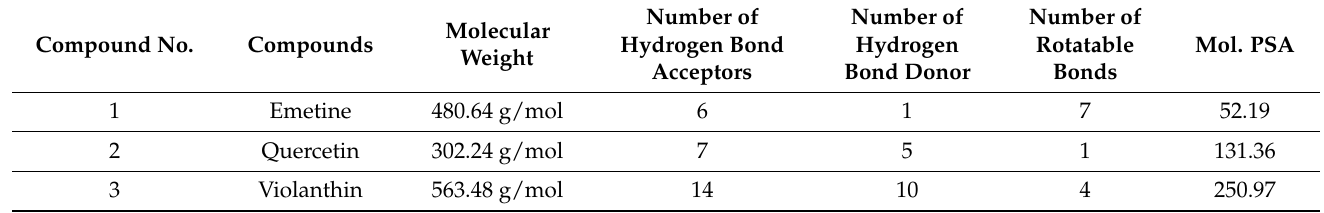
Table 4. Drug-likeness and physiochemical properties of Viola canescens compounds through Swiss ADMET